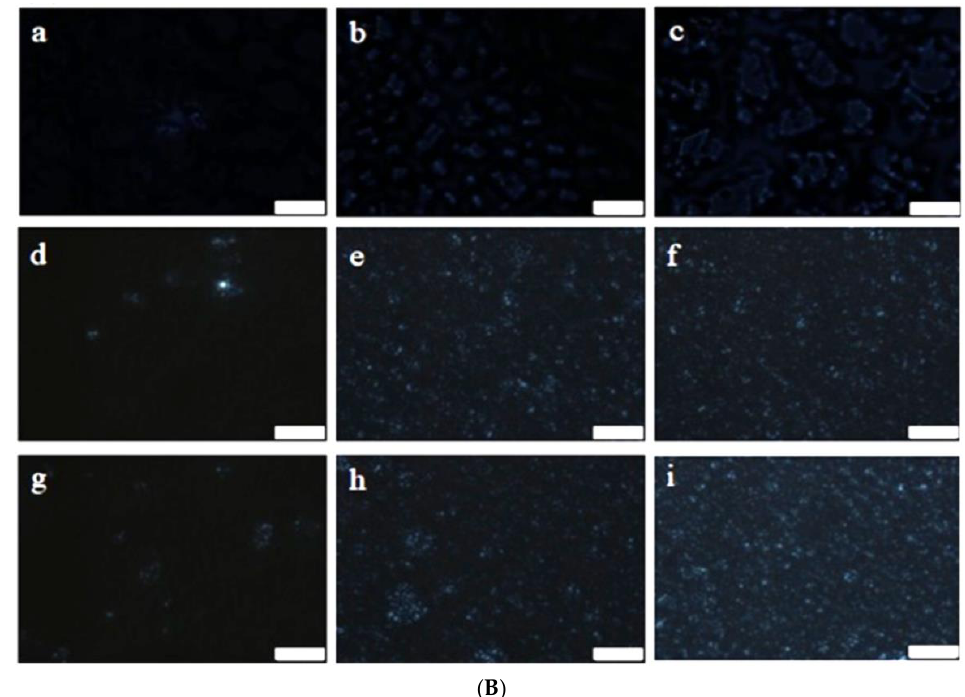
Figure 2. ( A ) Microscopic images of RoM fat crystals (white dots) using PLM (polarized light microscope) Images: ( a – c ) storage at − 20 ◦ C for 6 h, 6.5 h and 7 h, respectively; ( d – f ) storage at − 30 ◦ C for 2 h, 2.5 h min and 3 h, respectively; and ( g – i ) storage at − 40 ◦ C for 50 min, 1.5 h and 3 h, respectively. Scale bar is 20 µ m. ( B ) Microscopic images of SoM fat crystals (white dots) using PLM: ( a – c ) storage at − 20 ◦ C for 14 h 20 min, 15 h 50 min and 16 h 35 min, respectively; ( d – f ) storage at − 30 ◦ C for 11 h 50 min, 12 h 50 min and 13 h 20 min, respectively; and ( g – i ) storage at − 40 ◦ C for 4 h 20 min, 4 h 50 min and 5 h 5 min respectively. Scale bar is 20 µ m. Table 5. Induction time for generation of fat crystals in RoM and SoM.